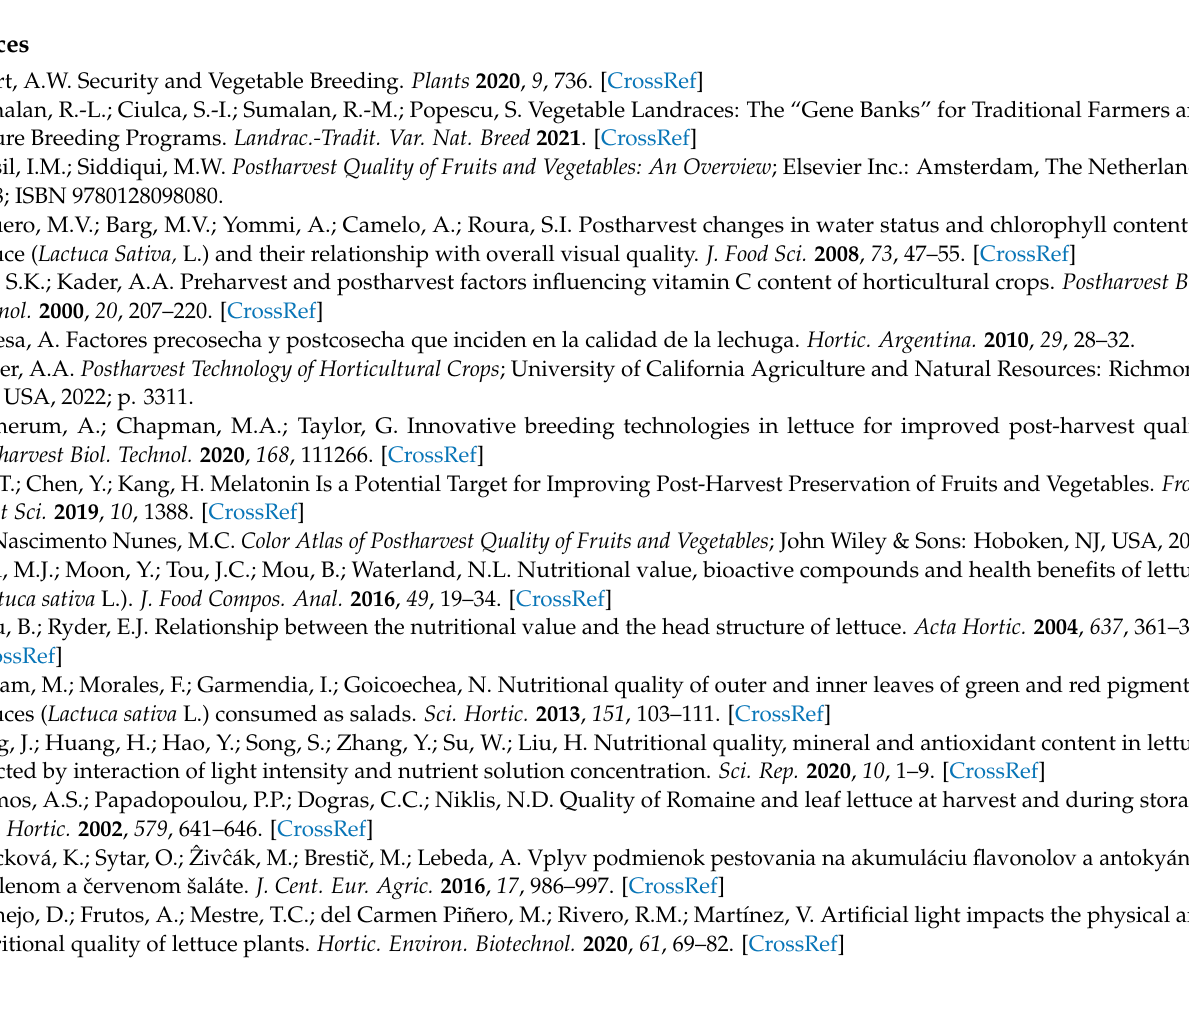
Table S2: Mineral concentration; Table S3: PCA